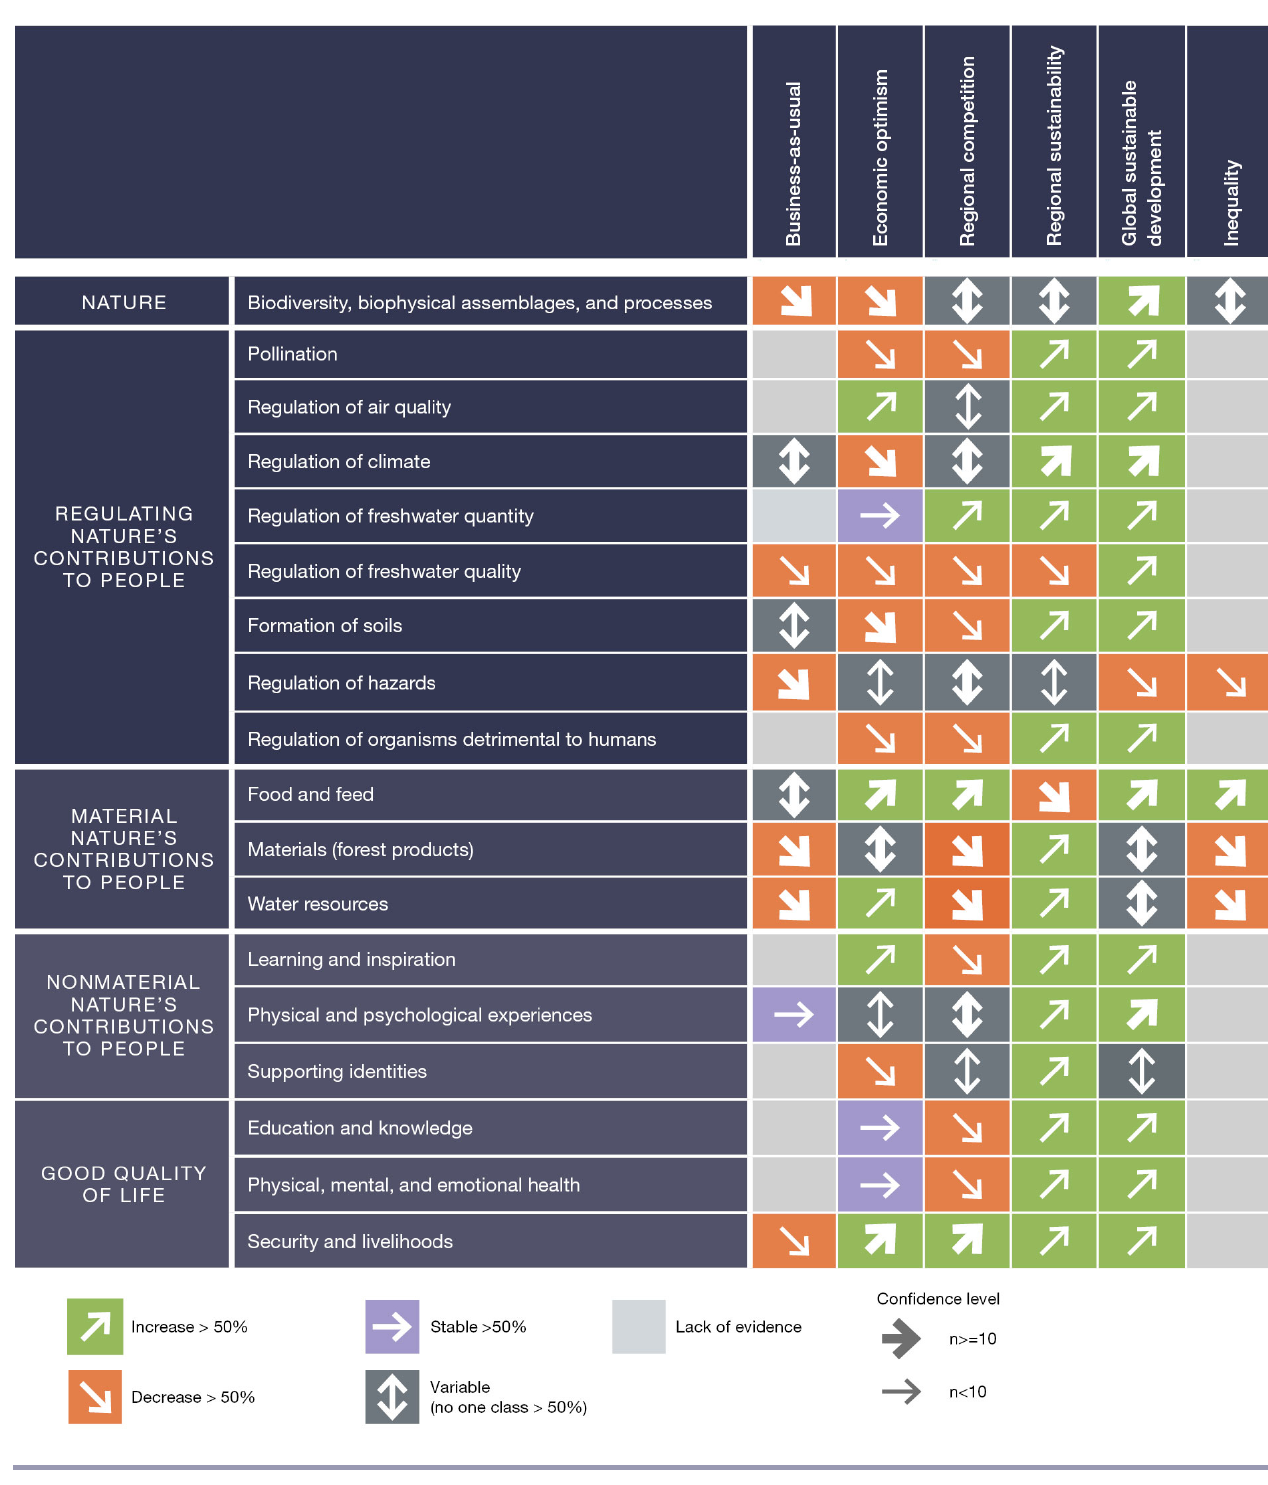
Fig. 2 . Projected future impacts on nature, nature’s contributions to people (NCP), and good quality of life according to the six scenario archetypes for Europe and Central Asia. Green symbols with upward arrow indicate an increase, orange symbols with downward arrow a decrease, and purple symbols with horizontal arrow a stable trend. Thick arrows indicate evidence from the modeling literature review is based on 10 or more model indicators per scenario archetype, thin arrows indicate evidence based on fewer than 10. Source: IPBES